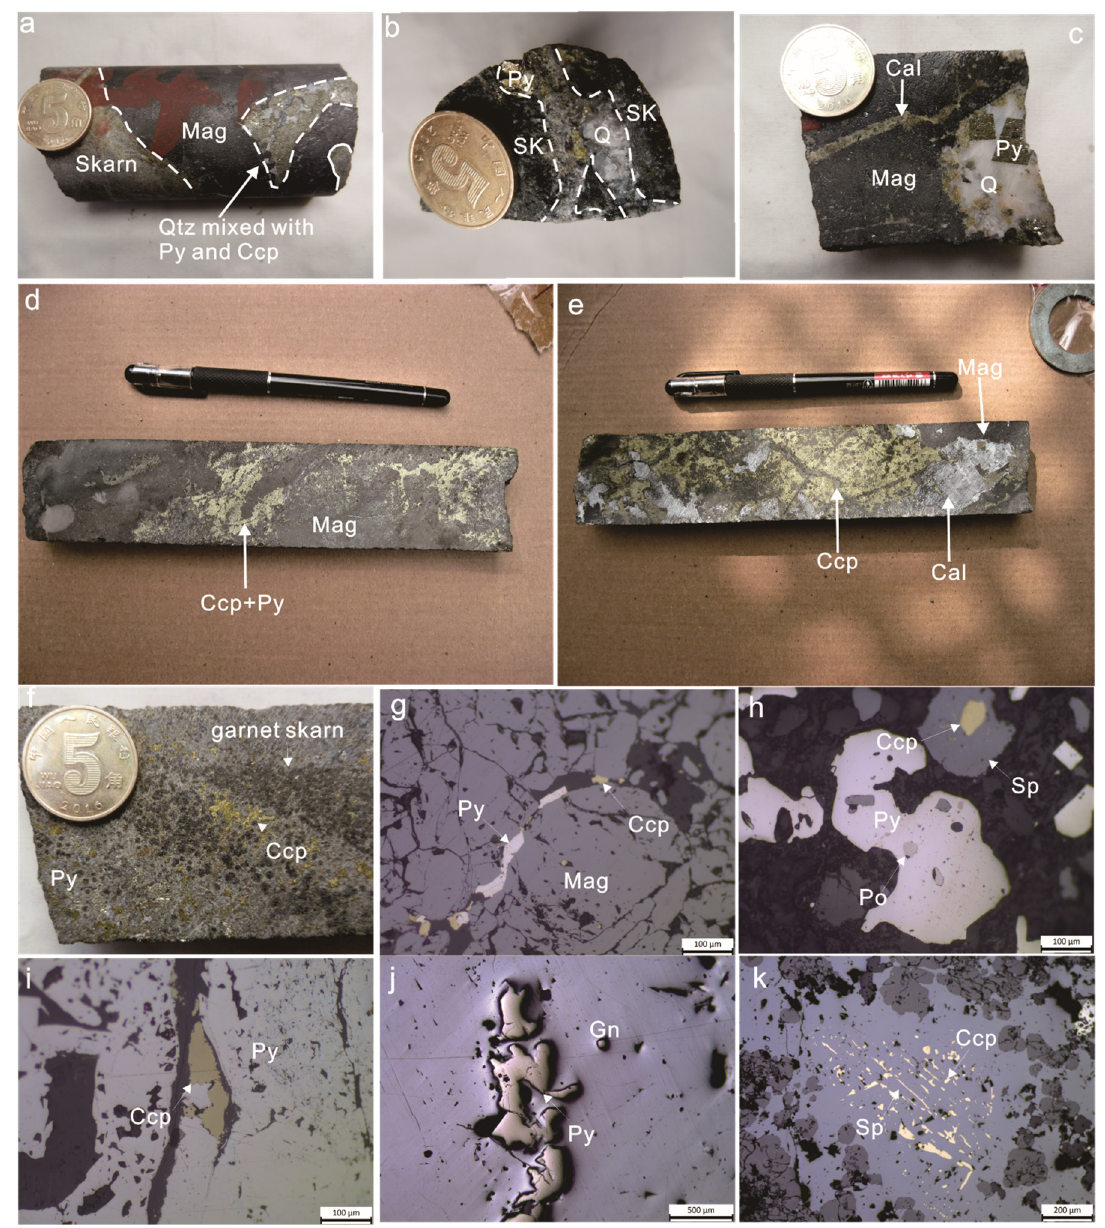
Figure 4. Typical ore hand specimens and microscopic photographs of the Shuikoushan deposit. ( a ) Magnetite replaced garnet skarn, pyrite-chalcopyrite-quartz veins interspersed within magnetite. ( b ) Pyrite-quartz vein crosscut skarns; ( c ) cubic pyrite grains in a quartz vein, note that a calcite vein crosscut magnetite. ( d ) Chalcopyrite and pyrite stringers and veinlets within the magnetite-bearing ore. ( e ) Massive chalcopyrite occurs together with calcite veins and blebs. ( f ) Disseminated to semi-massive pyrite and chalcopyrite within a garnet skarn. ( g ) Pyrite and chalcopyrite infilled into fissures of magnetite grains. ( h ) Chalcopyrite and pyrrhotite were enclosed by sphalerite and pyrite, respectively. ( i ) Chalcopyrite replaced pyrite along fissures of pyrite. ( j ) Harbor-shaped and island-like pyrite was replaced by galena. ( k ) Chalcopyrite was replaced by sphalerite, resulting in the ‘chalcopyrite disease’ texture. Abbreviations: Cal—calcite, Ccp—chalcopyrite,